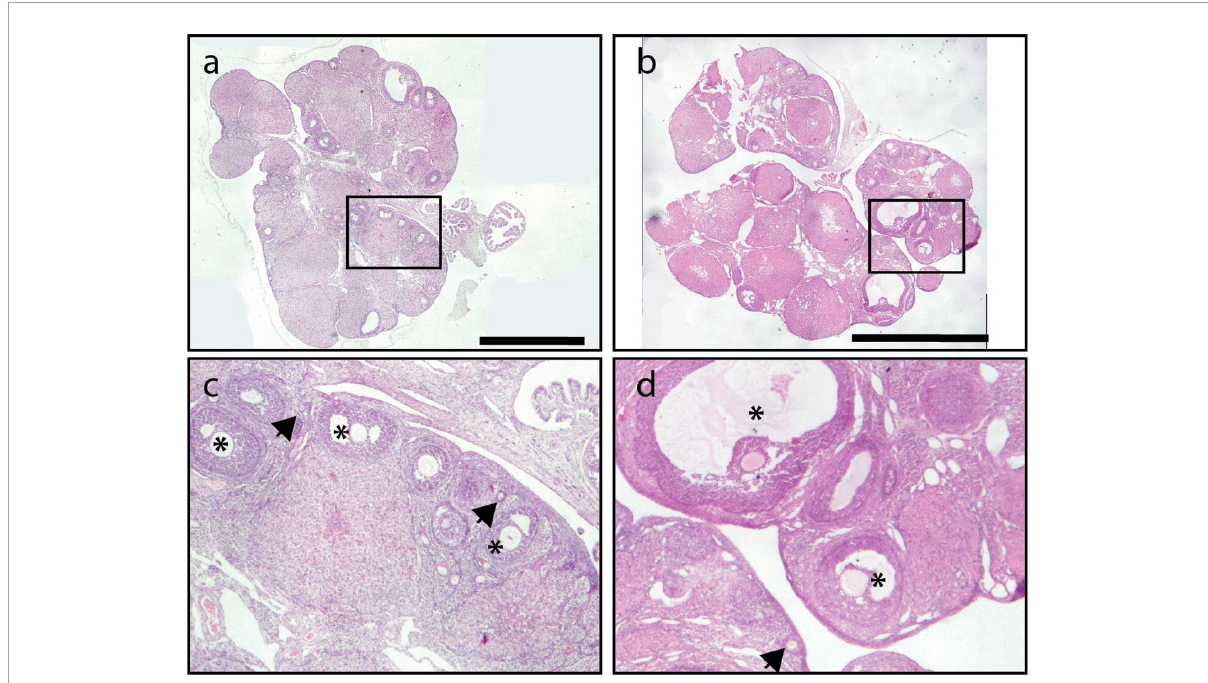
FIGURE10 Example of an ovary from a rat exposed to LL followed by 3 weeks of 12-h feeding protocol distributed in four pulses feeding events every 3 h as a rescue strategy (LL + PR) (a,c) and an ovary from a rat exposed simultaneously to four food pulses as a preventive strategy for 6 weeks (LL + PP) (b,d) . Primary follicles are indicated with arrowheads and growing follicles with asterisks. Scale bar = 2